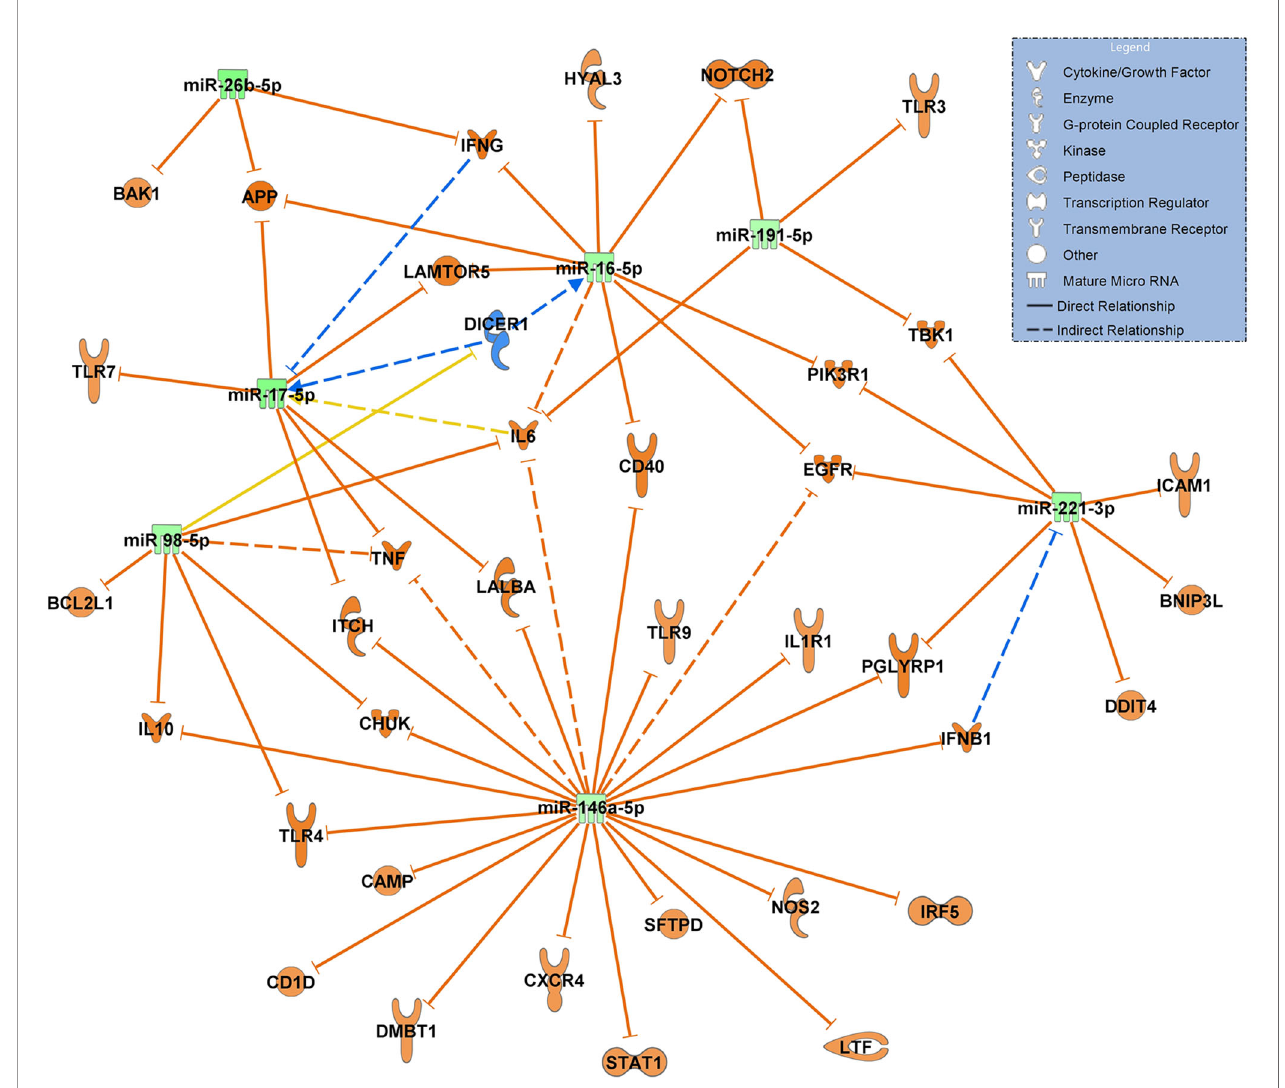
FIGURE 7 | Changes in miRNA signalling networks during ICU treatment of patients with COVID-19 ARDS based on small RNA sequencing data. miRNA expression values between day 0 (admittance to the ICU, baseline, n=15) and day 14 of ICU treatment (n=13) were compared. All miRNAs in the network were downregulated represented by green colouring and their presumed targets by orange colour. Yellow lines indicate undetermined regulatory effects because the transcripts were targeted by miRNAs with different directions of regulation. Solid lines indicate direct and dashed lines indirect relationships. Data from small RNA sequencing were fi ltered for antimicrobial response and lung as an organ system and con fi dence levels were set to experimentally observed. The legend inserted into the graph illustrates the type of target molecules according to the symbols used in the